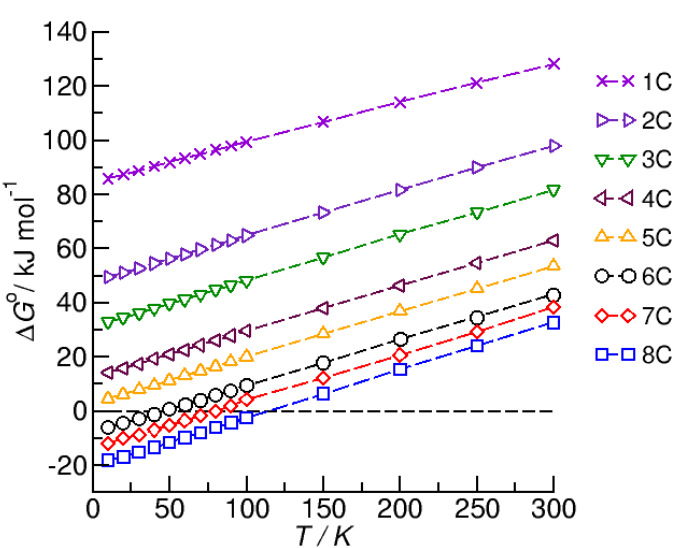
Figure 7. Calculated standard-state free energies ∆ G ◦ of the cationic dimers (HCOO − (CH 2 ) n − py + ) 2 for n = 1–8. Negative free energies were calculated for (HCOO − (CH 2 ) 6 − py + ) 2 , (HCOO − (CH 2 ) 7 − py + ) 2 , and (HCOO − (CH 2 ) 8 − py + ) 2 at temperatures below 47, 80, and 114 K.